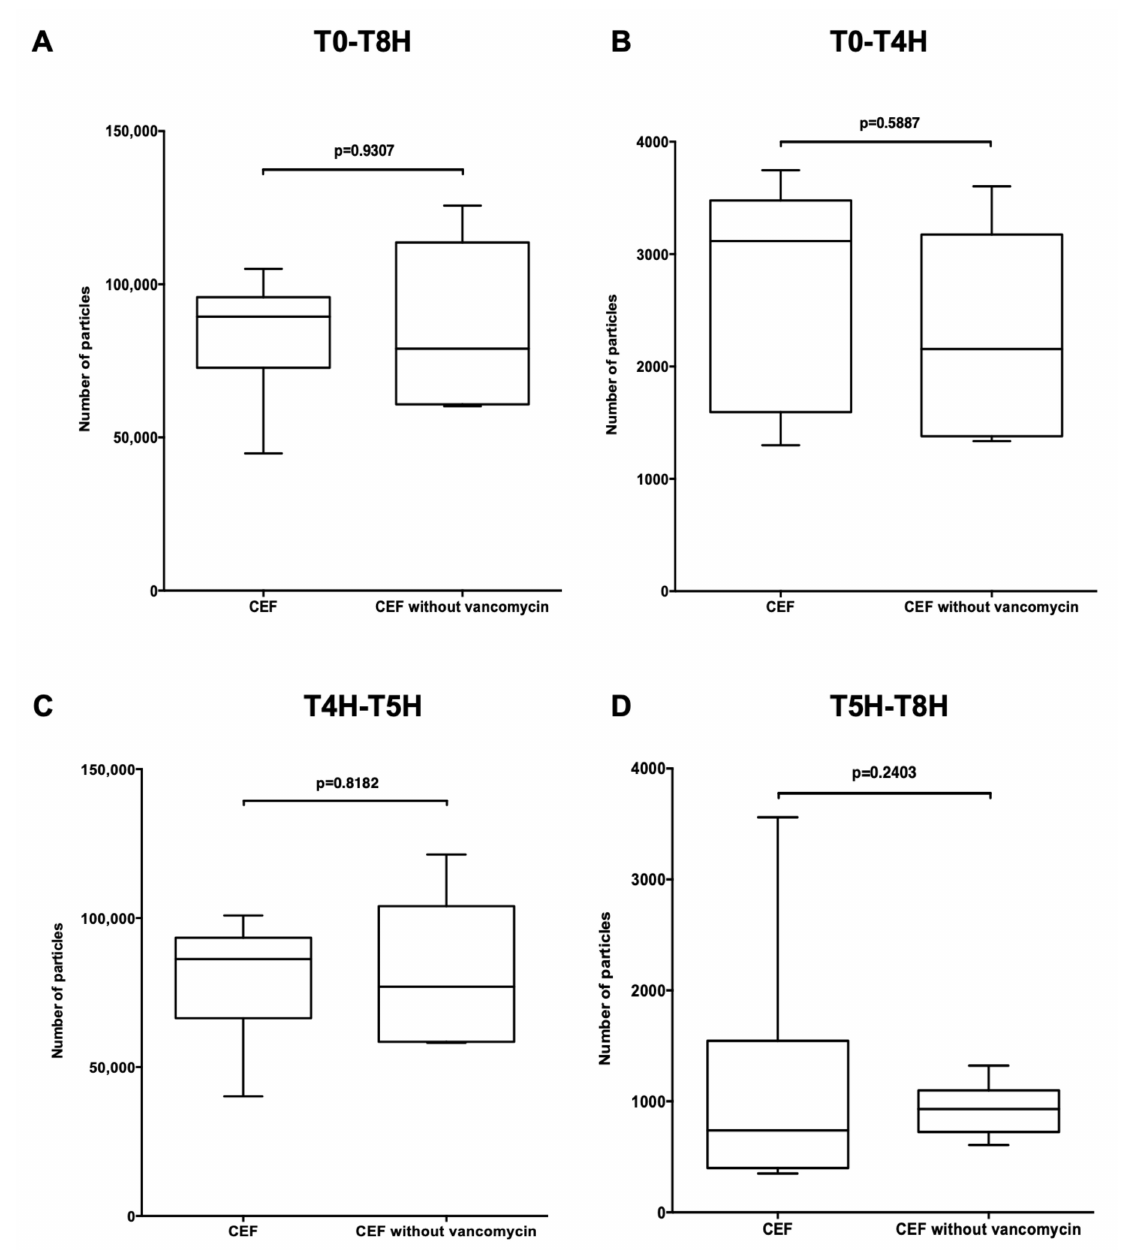
Figure 7. Impact of replacing vancomycin with a G5% infusion on particulate load. Comparison of total particulate load as a function of vancomycin/G5% infusion at times T0-T8H ( A ); T0-T4H ( B ); T4H-T5H ( C ); T5H-T8H ( D ). CEF: infusion line with cefepime on emergency route and with vancomycin; CEF without vancomycin: infusion line with cefepime on emergency route and with replacement of vancomycin by G5%. Results are expressed as medians [min; max] (Mann Whitney, p < 0.05, n =